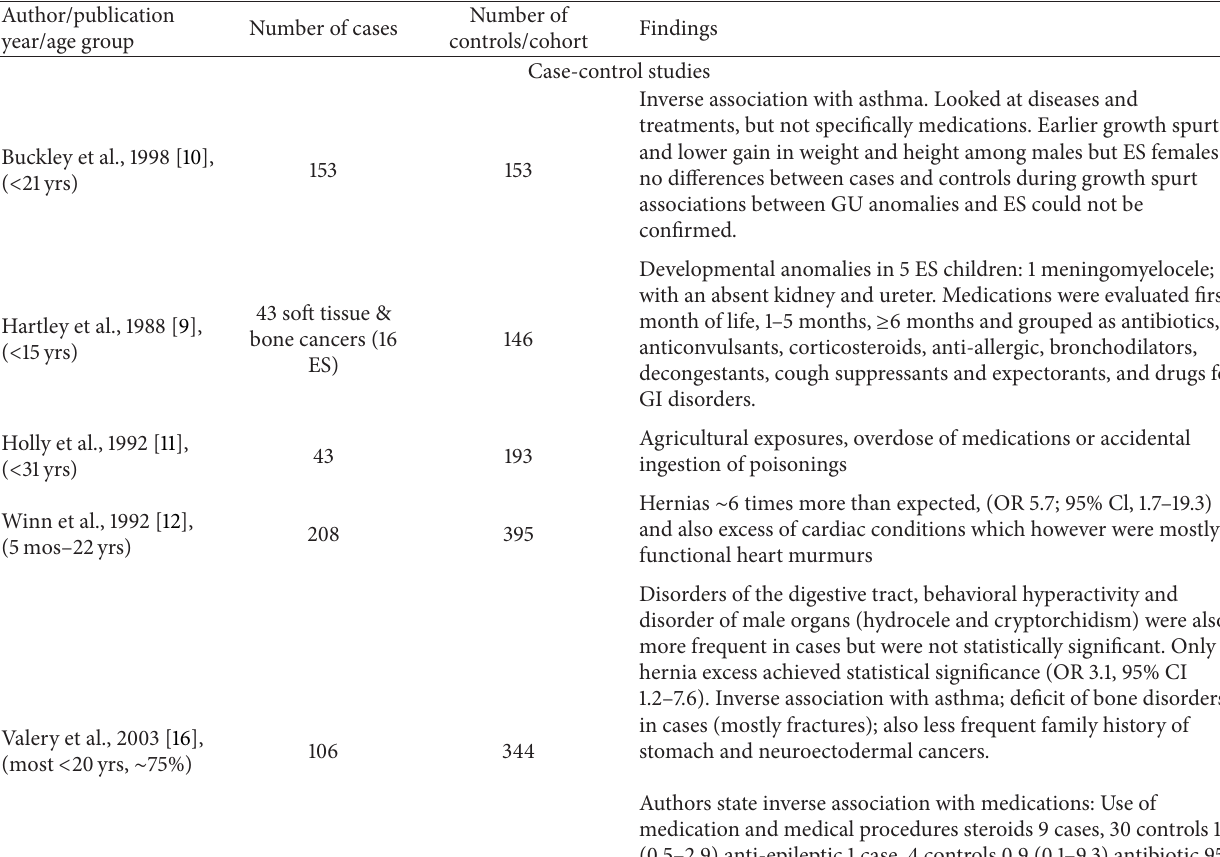
Table 4: ESFT-related